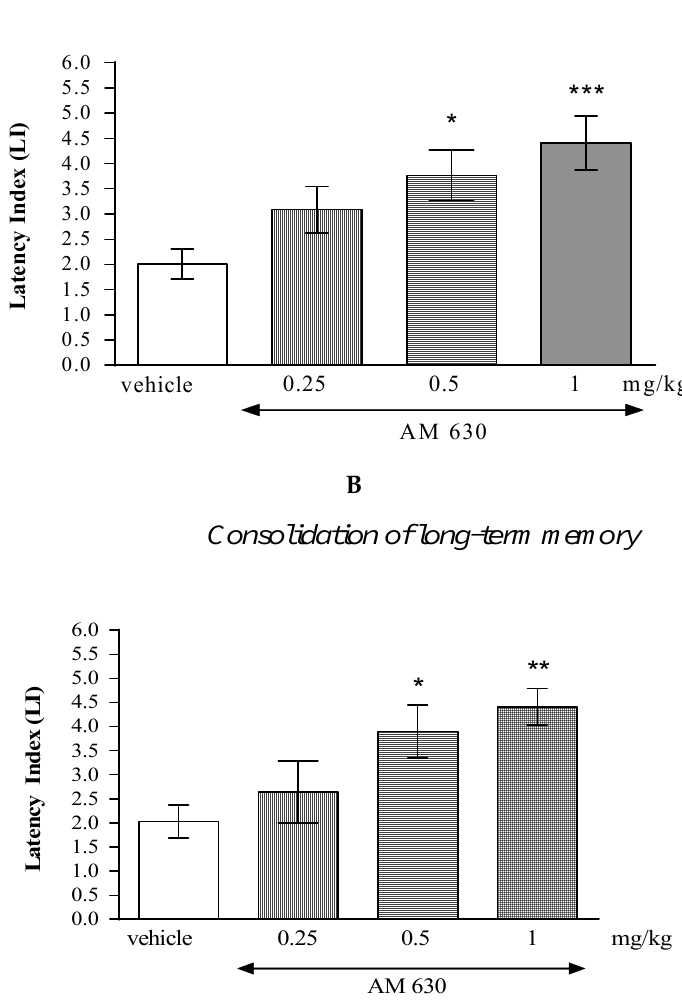
Figure 3. The influence of an acute administration of AM 630 on the cognition-related responses, expressed as latency index (LI), during the acquisition ( A ) and consolidation ( B ) of memory using the PA test in mice. AM 630 (0.25, 0.5 or 1 mg/kg) or vehicle were administered 30 min before the first trial (acquisition of memory) or immediately after the first trial (consolidation of memory). The second trial was conducted 24 h after the first one; n = 8–10; the means ± SEM; * p < 0.05; ** p < 0.01; *** p < 0.001 vs. vehicle ‐ treated group; Tukey’s test.